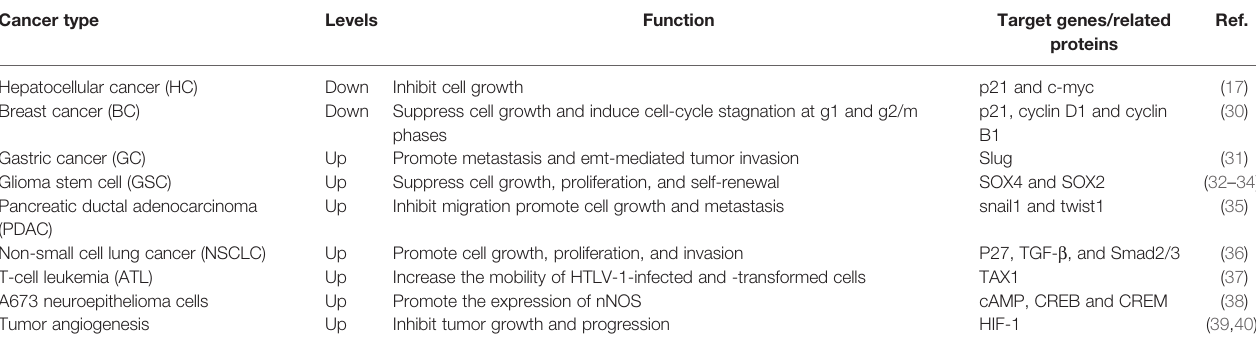
TABLE 1 | The expression and roles of FHL3 in different human cancers.